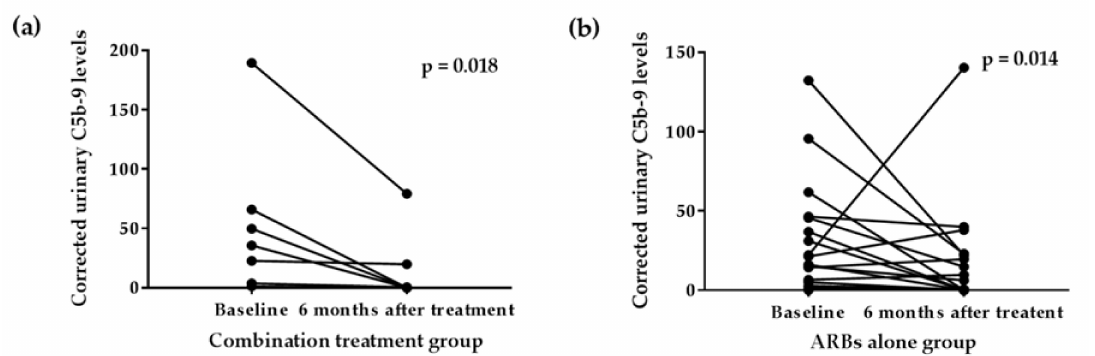
Figure 3. Changes in urinary complement C5b-9 levels in ( a ) combination treatment group (patients who were treated with angiotensin receptor blockers (ARBs) and immunosuppressive agent) and ( b ) ARBs alone group at 6 months after medical treatment. Data were analyzed by Wilcoxon matched- pairs signed-rank